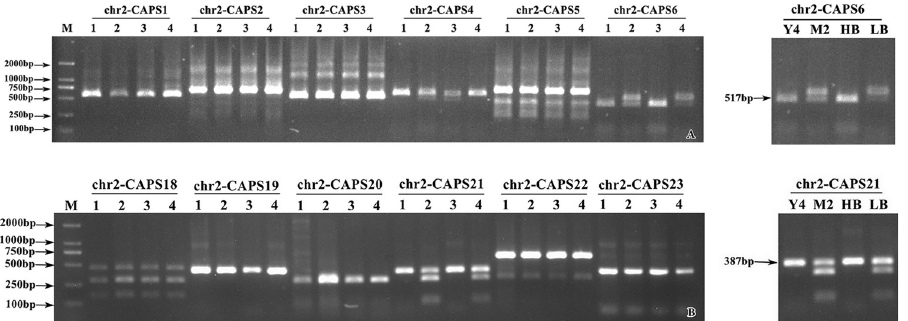
Fig 4. The screening of partial CAPS primers for potato. (A) chr2-CAPS6 enzyme digestion electrophoresis. (B) chr2-CAPS21 enzyme digestion electrophoresis. M. DL2000 Marker; 1. ♀ YSP-4; 2. ♂ MIN-021; 3. high starch pool; 4. low starch pool; chr2-CAPS1, chr2-CAPS2, chr2-CAPS3, chr2-CAPS4, chr2-CAPS5, chr2-CAPS6, chr2-CAPS18, chr2-CAPS19, chr2-CAPS20, chr2-CAPS21, chr2-CAPS22 and chr2-CAPS23 represents the partial primer.